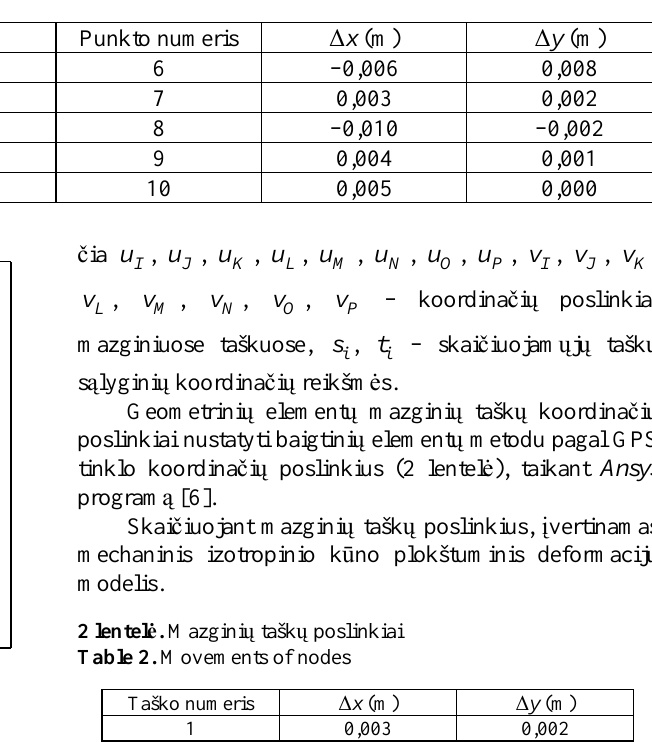
Table 1. Alterations of point coordinates